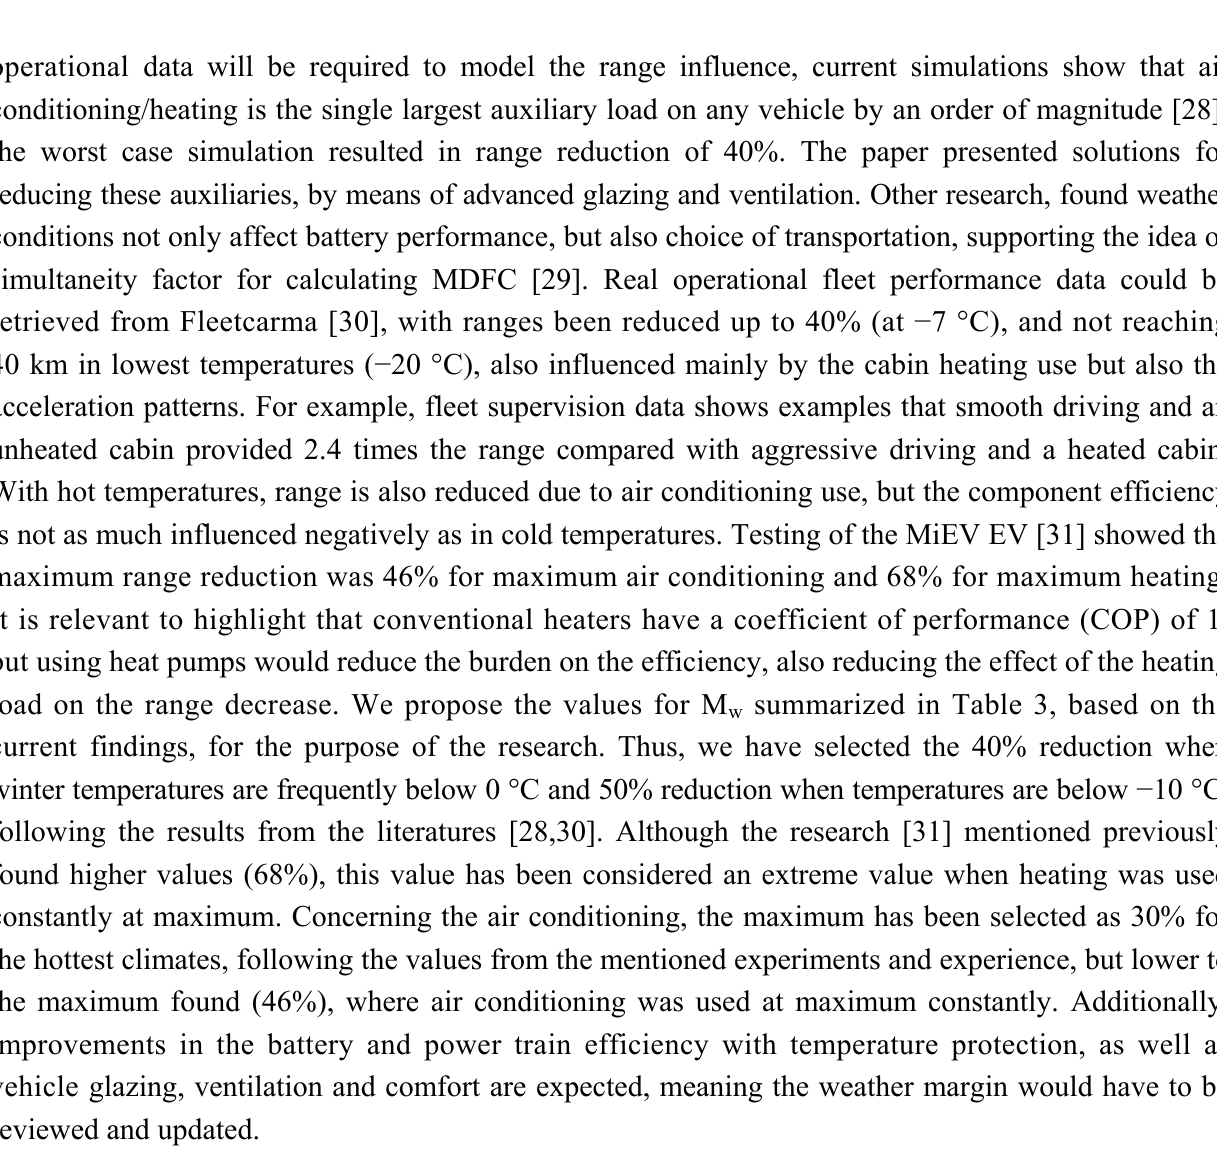
Table 3. Weather margin ( M